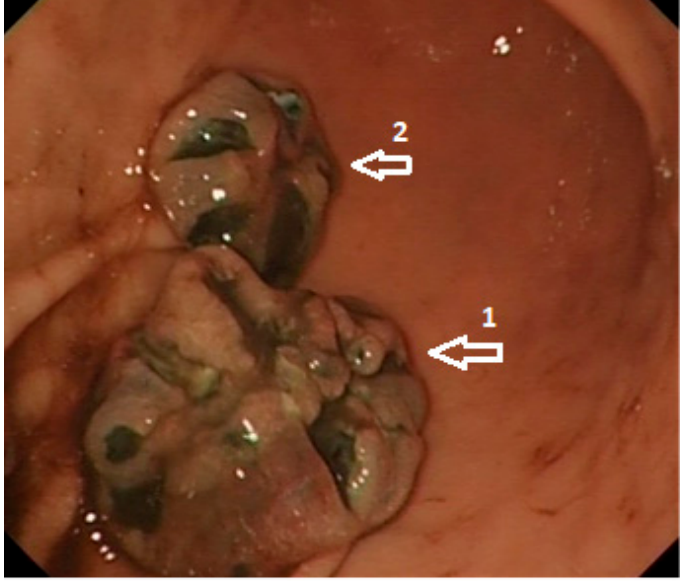
Figure 1. High ‐ definition white light endoscopy: Metastatic malignant melanoma involving the distal body (size: 20 × 15 mm; 1) and proximal antrum (size: 15 × 10 mm; 2) of the stomach.